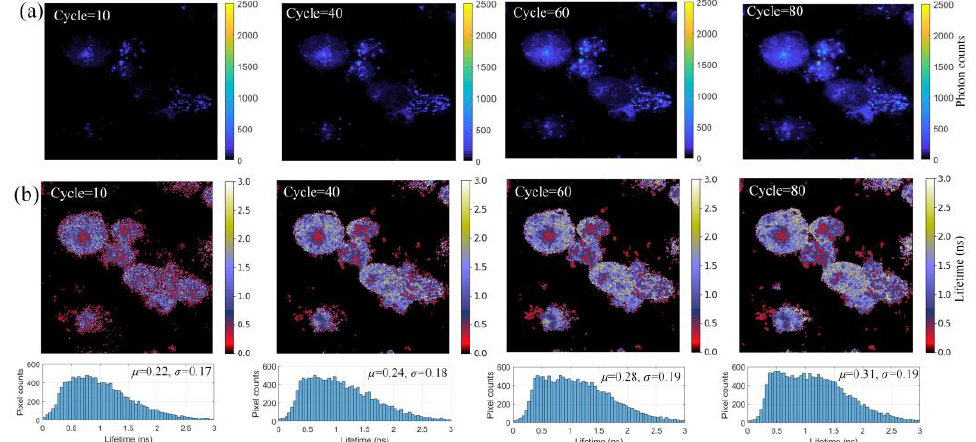
Figure 9. ( a ) Intensity images with different scales of colorbars, scanning cycles were set to 10, 40, 60, and 80. Colorbars are unified. ( b ) τ A images and pixel occurrence reconstructed by ELM in different cycles.